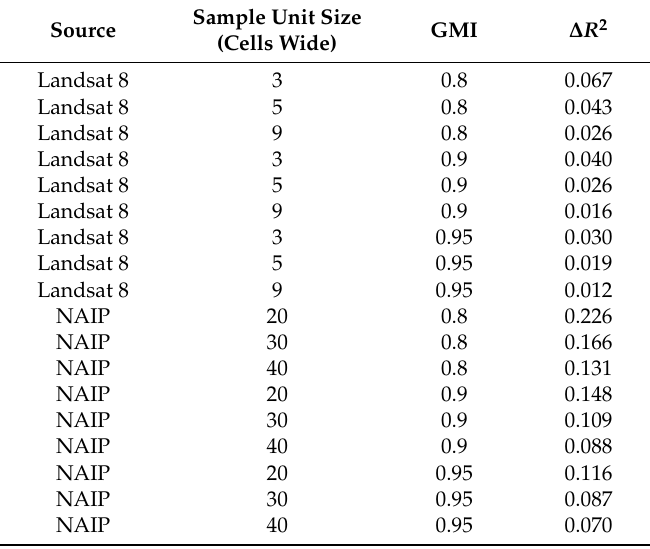
Table A2. Estimated reduction in R 2 ( ∆ R 2 ) for Landsat 8 and NAIP imagery given Equation (4), sample unit size, GMI value, and published horizontal image and GPS